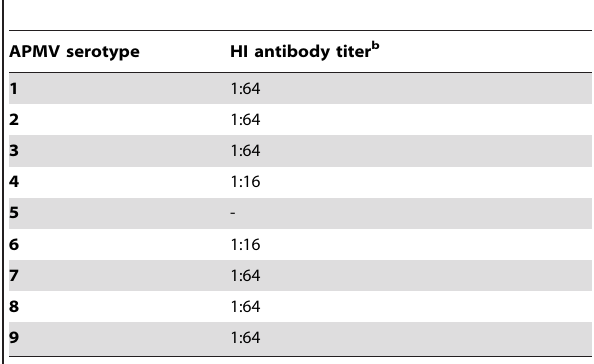
Table 3. Serum antibody responses against APMV serotypes 1–9 in infected mice a